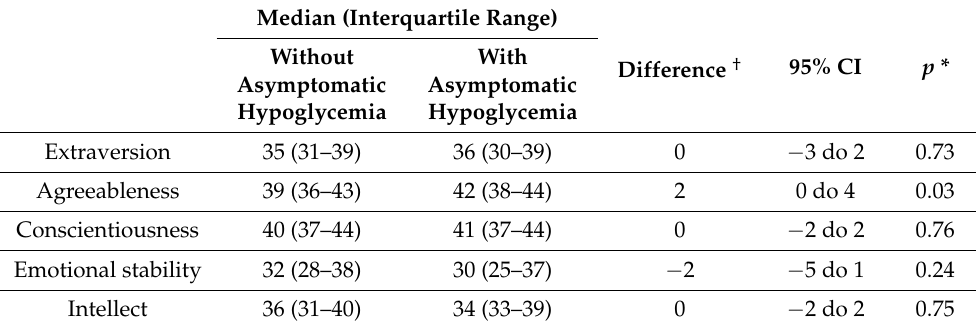
Table 9. Differences in personality dimensions related to asymptomatic hypoglycemia